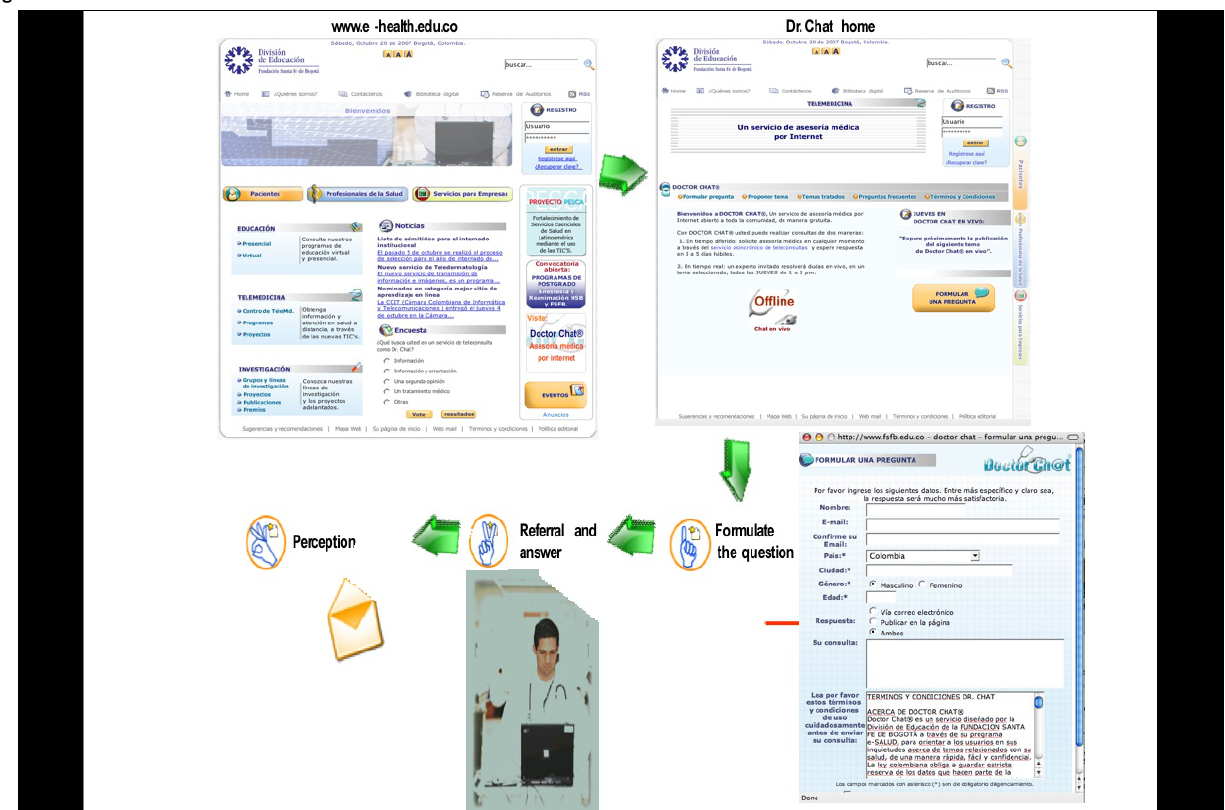
Figure 2. Doctor Chat: how does it